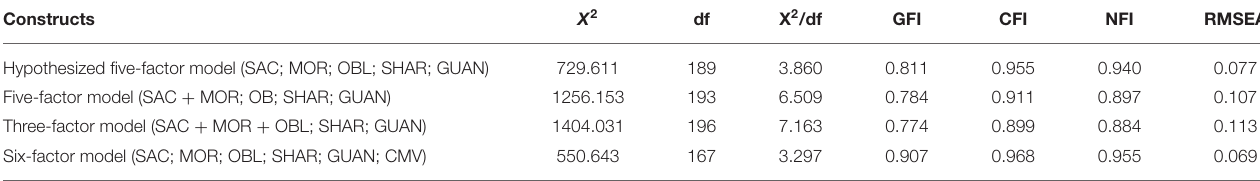
TABLE 1 | Discriminant validity and common bias test. Constructs